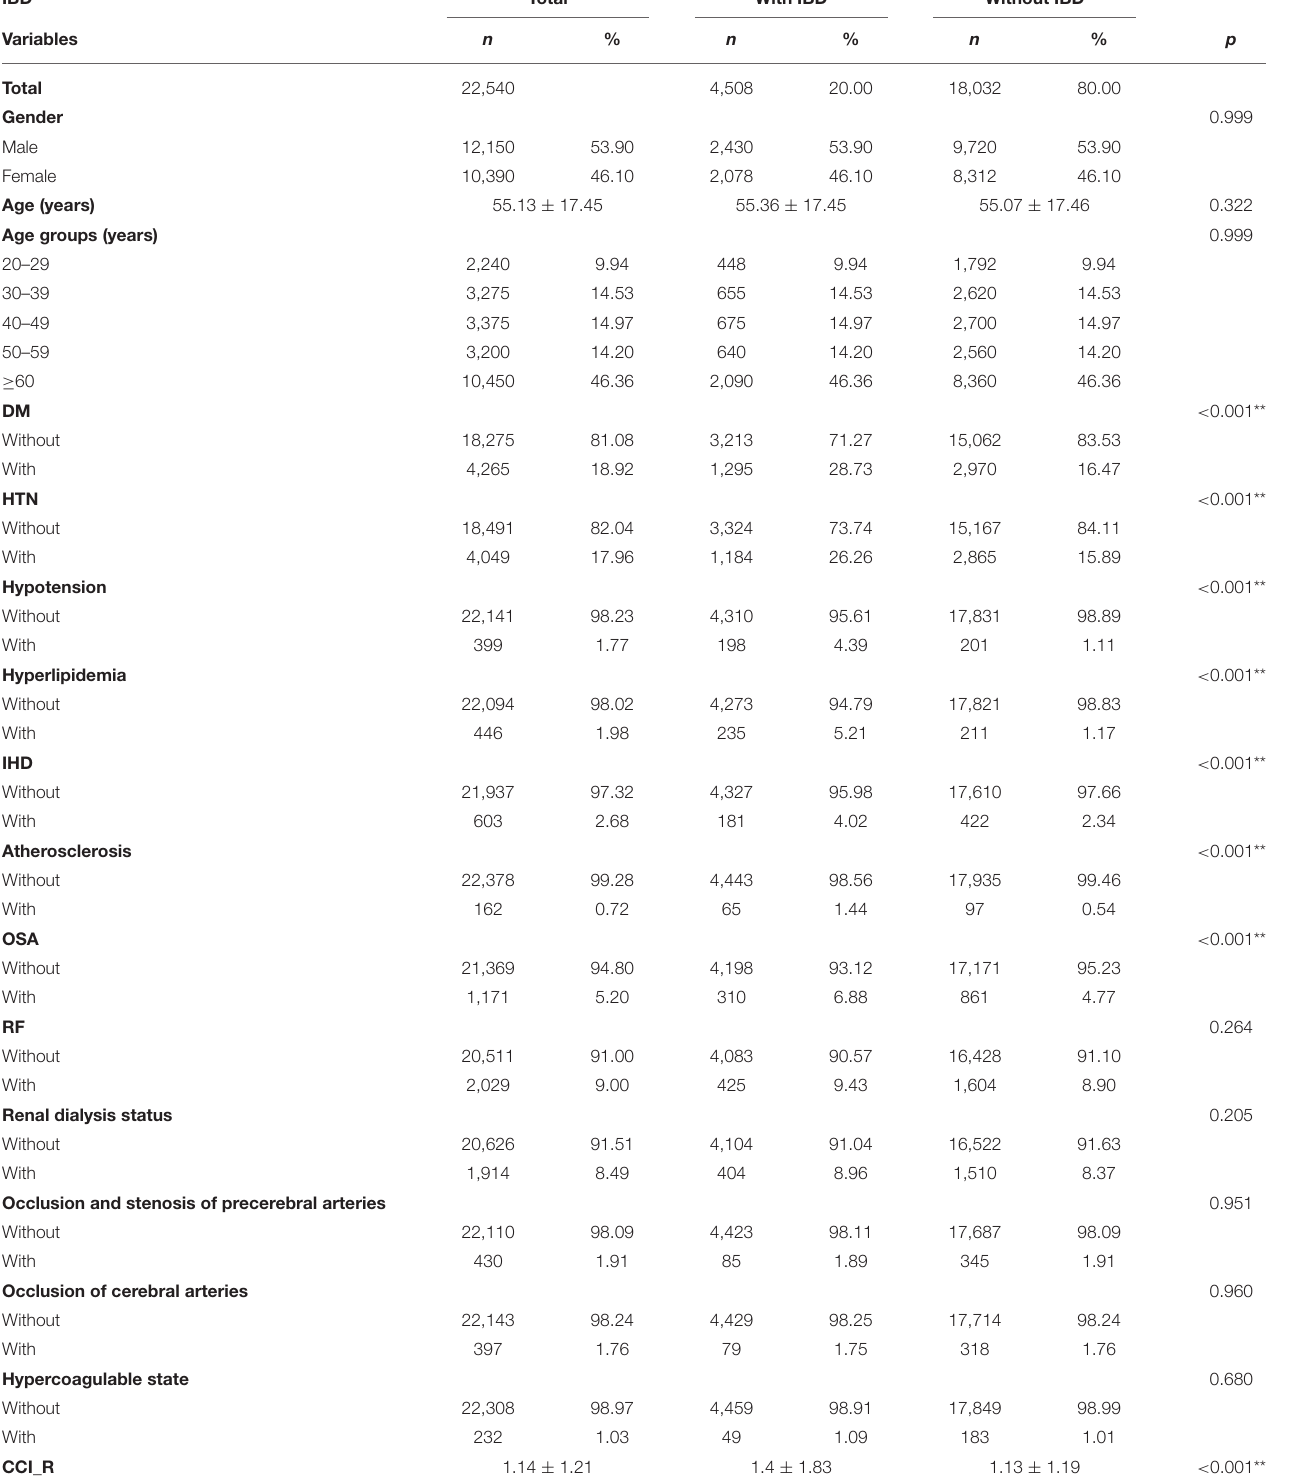
TABLE 1 | The demographic characteristics of the enrolled patients at baseline. IBD Total With IBD Without IBD Variables